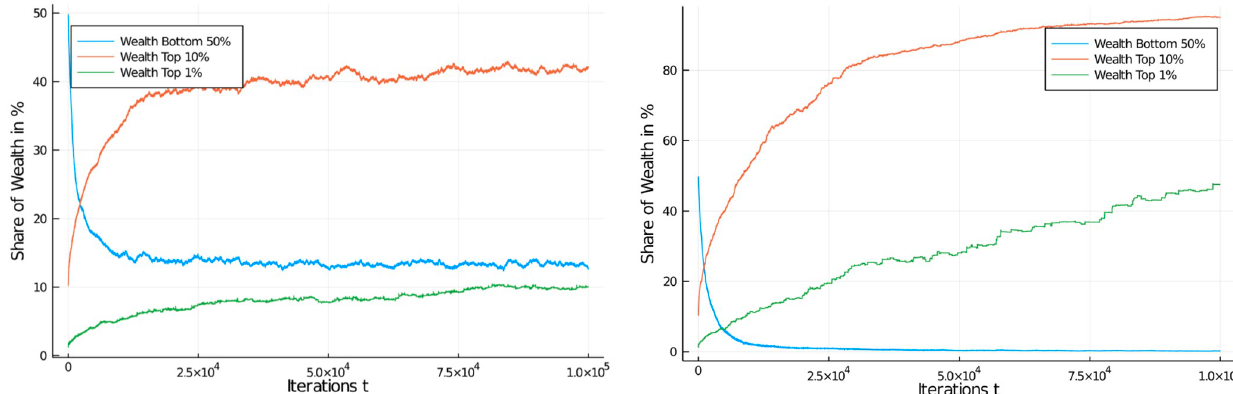
Fig 7. Comparison of different flat income tax regimes. Wealth development in different quantiles of the population of 1,000 agents. Initial distribution was equal among all 1,000 agents. Quantiles shown: Bottom half of the population vs top 10% and top 1% wealthiest agents. Comparison of flat income tax regime, with high flat tax of 60% (left) and low flat tax of 5%